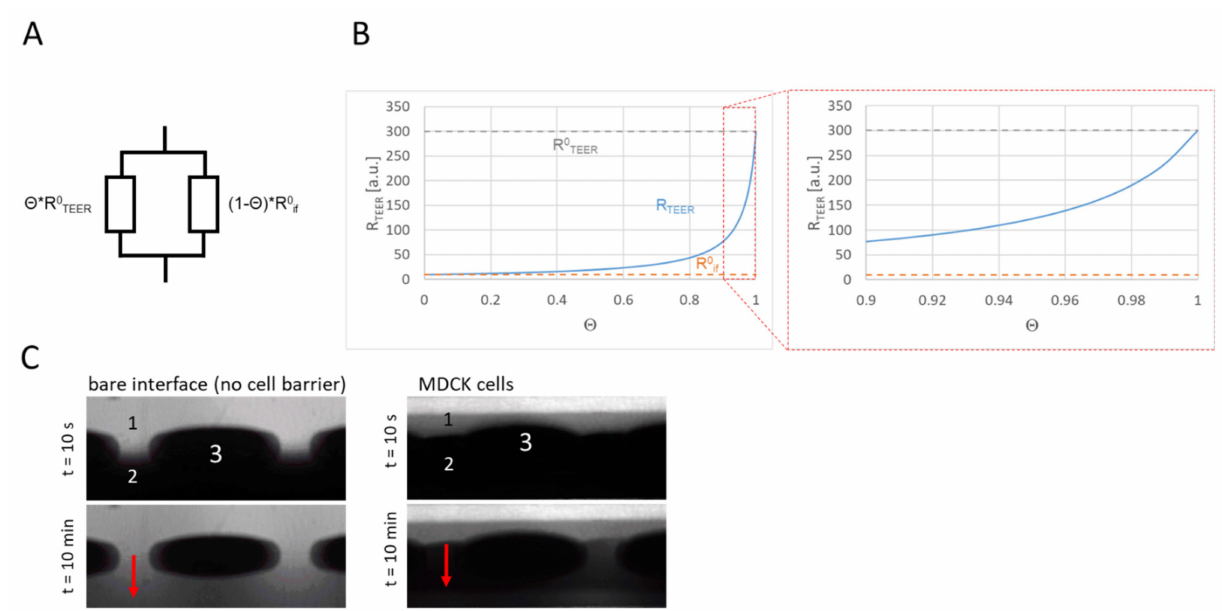
Figure A3. Measurement of barrier tightness. ( A ) R TEER can be estimated by assuming a parallel connection of the specific resistance, R 0 TEER , on area fractions, Θ , of the interface covered by the cell layer and the specific resistance, R 0 if , of the bare interface on the remaining area fraction (1 − Θ ), according to ( B ) Simulation of the resistance, R TEER , as a function of coverage of the interface. As the resistance of the bare interface, R 0 if , will be much smaller when compared to R 0 TEER , even very small area fractions (1 − Θ ) uncovered by the cell layer will result in a significant reduction in apparent R TEER measured by impedance spectroscopy. This simulation demonstrates the sensitivity and usefulness of impedance measurement in assessing the tightness of the cell layer. ( C ) FITC-dextran (MW = 4 kD) was placed in the perfusion channel and diffusion into the gel phase was monitored by fluorescence video microscopy to assess barrier tightness. 1: perfusion channel, 2: gel phase, 3: pillar. The red arrow indicates the concentration gradient and the direction of diffusion from the perfusion channel into the gel phase. In the absence of a cell layer (left), a significant increase in fluorescence intensity in the gel phase was observed after 10 min, which is indicative of diffusion of the tracer from the perfusion channel into the gel phase, whereas a cell layer comprised of MDCK cells (right) prevented diffusion of the tracer into the gel. Table A1. Dimensions of the MFC